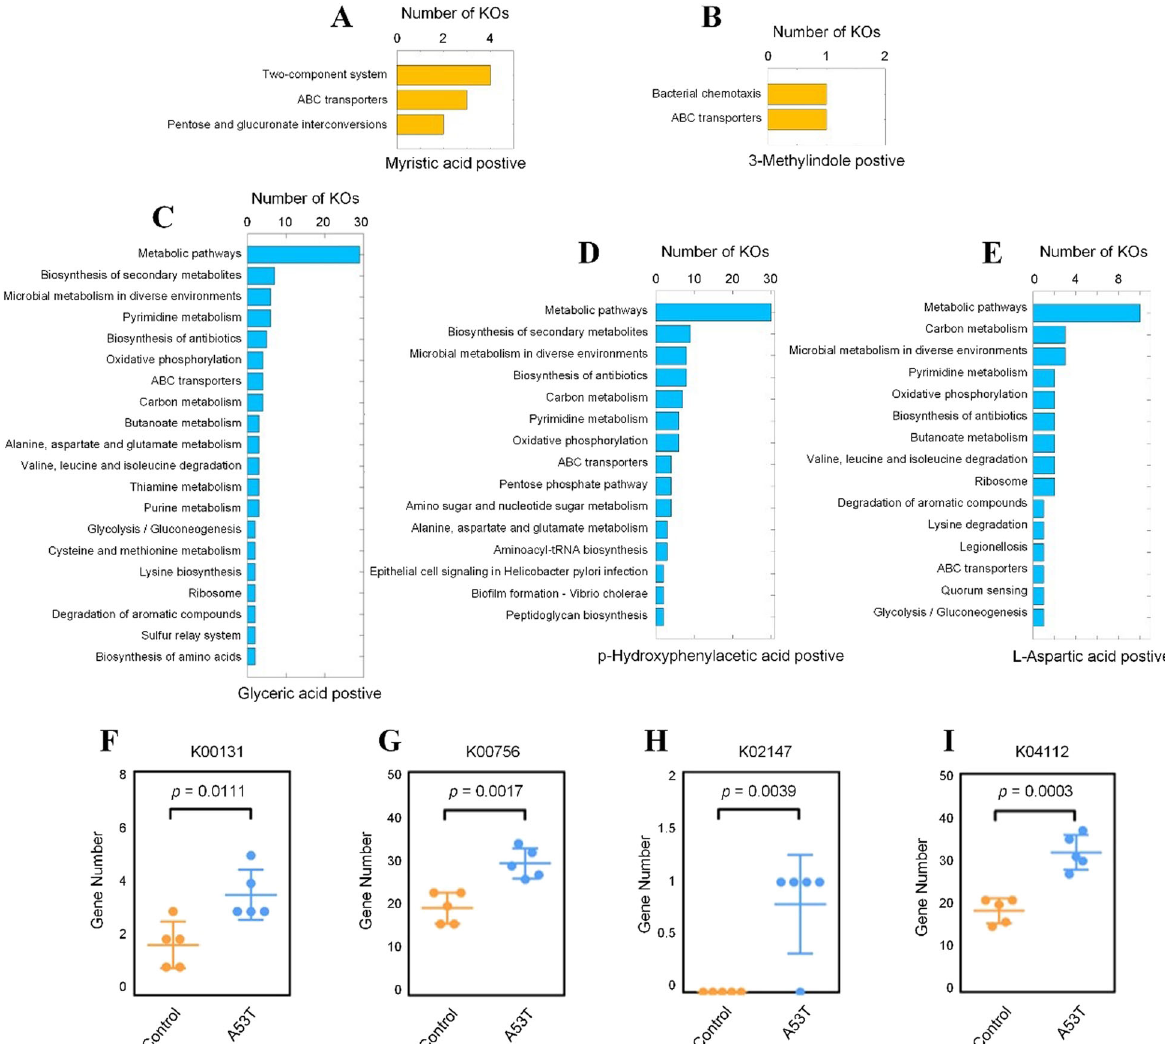
Fig. 4 Analysis of enriched pathways for the fi ve differential metabolites. A – B Metabolite-enriched pathways signi fi cantly ( p < 0.05) associated with control monkeys. C – E Metabolite-enriched pathways signi fi cantly ( p < 0.05) associated with A53T transgenic monkeys. F – I Four KOs from metabolic pathways that are signi fi cantly ( p < 0.05) elevated in the transgenic A53T